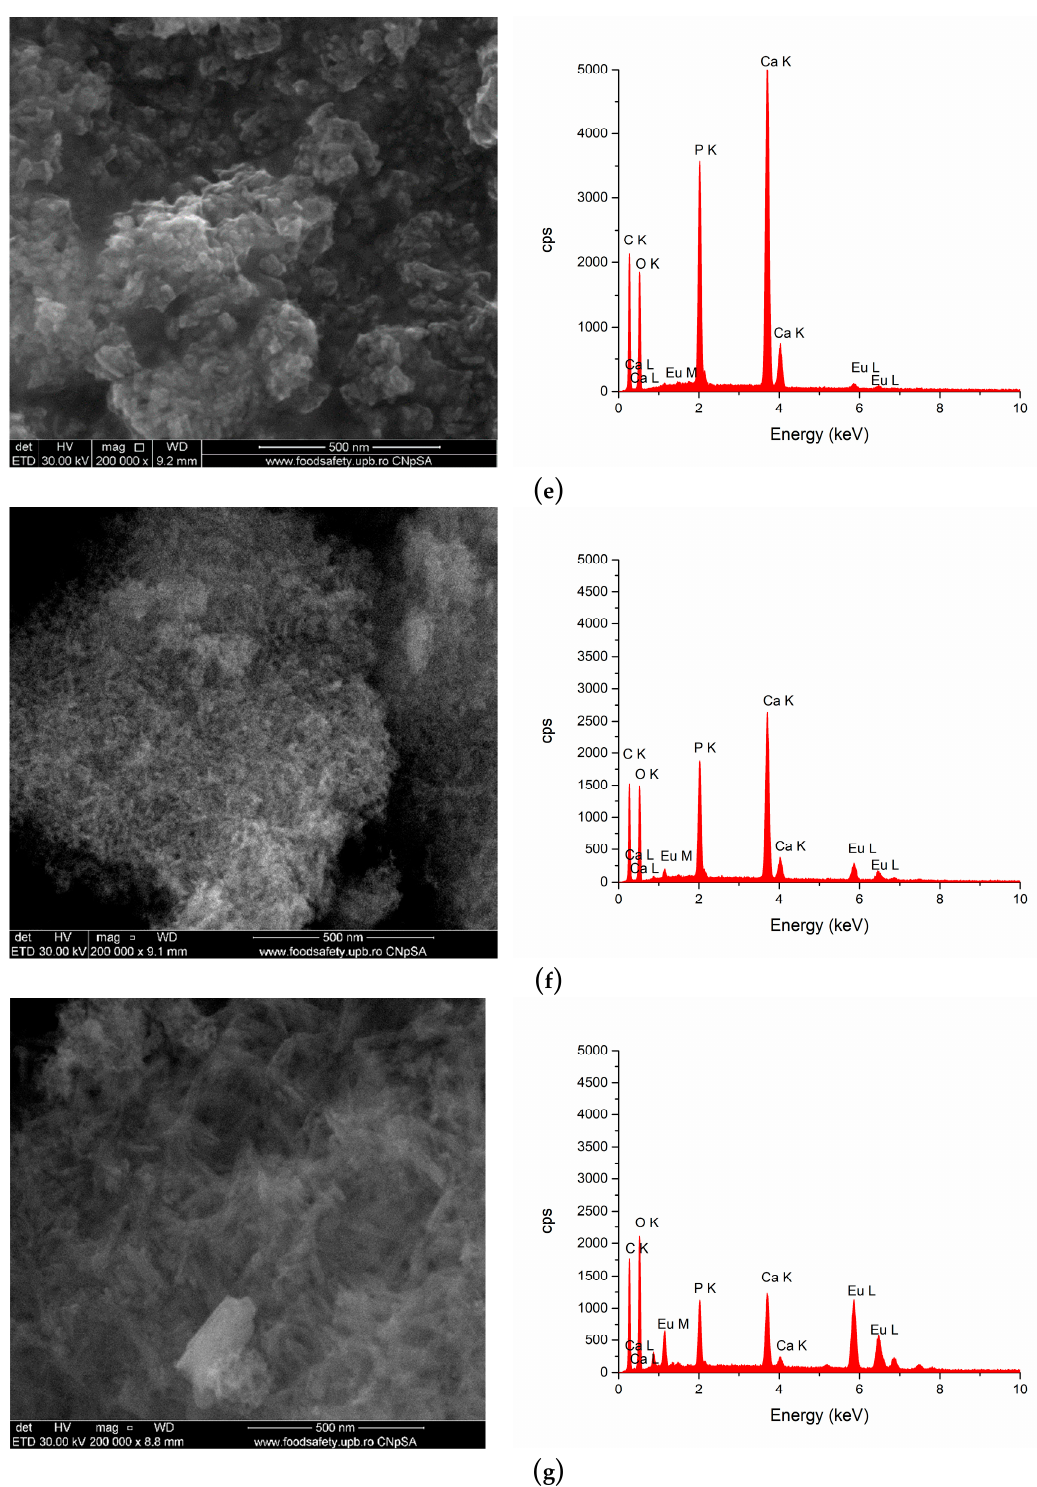
Figure 4. The SEM images (column A ) and EDX spectra (column B ) of pure HAp and Eu X HAp samples ( a ) HAp, ( b ) Eu0.5HAp, ( c ) Eu1HAp, ( d ) Eu1.5HAp, ( e ) Eu2HAp, ( f ) Eu10HAp, ( g ) Eu50HAp.